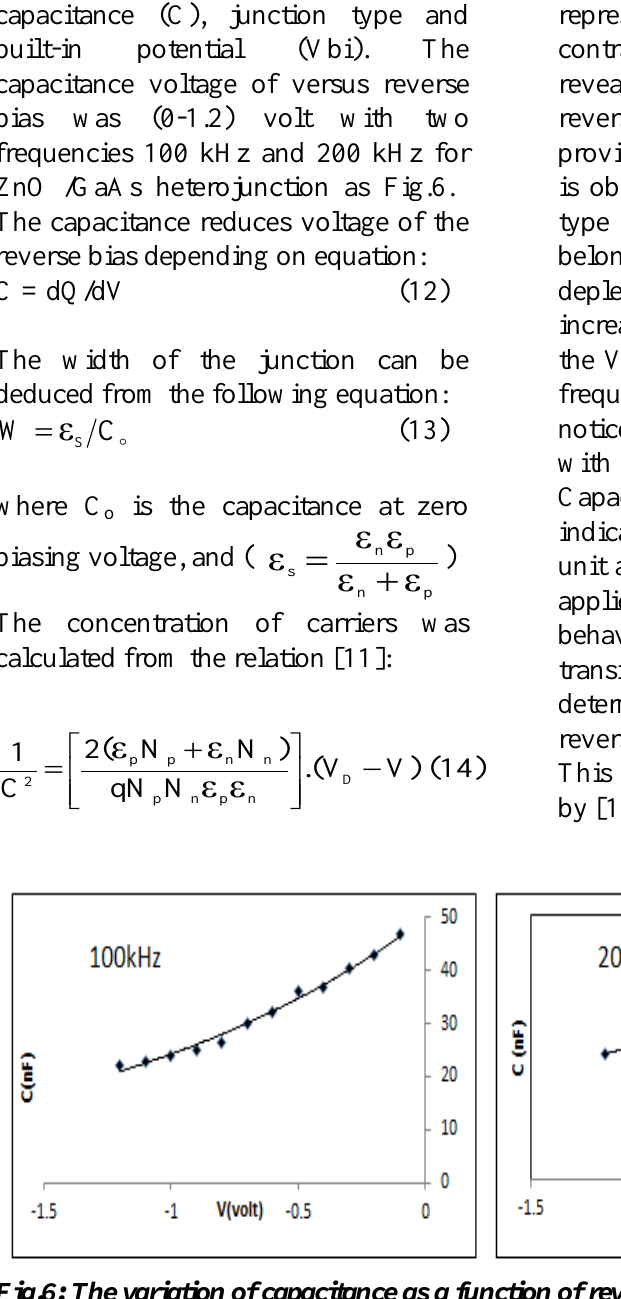
Fig.6: The variation of capacitance as a function of reverse bias voltage for ZnO/GaAs heterojunction at frequencies100 kHz and 200